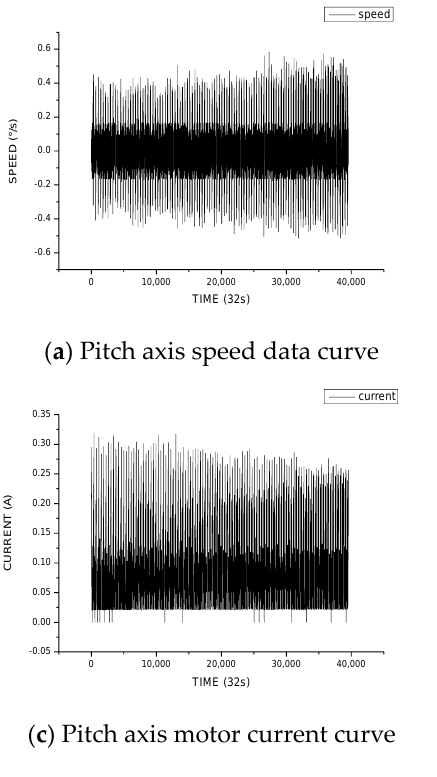
Figure 9. Data feature curves of pitch axis.